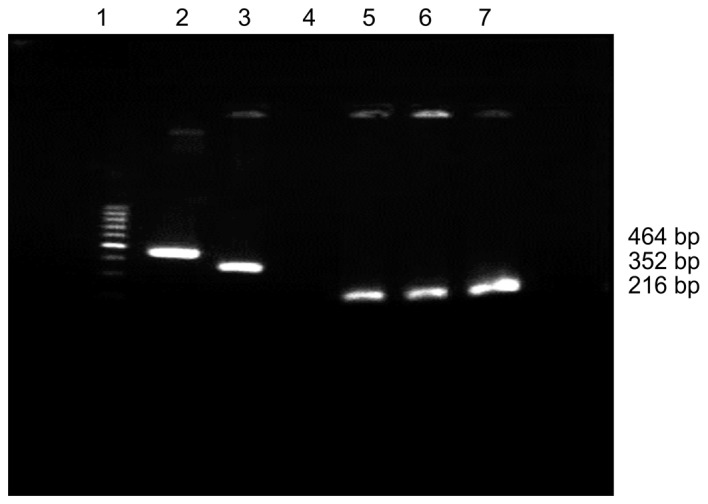
Hepatitis B viral virus X protein (HBx) fragments amplified by PCR from pAS2-1 recombinant plasmid and separated by gel electrophoresis (0.6% agarose). The different fragments have the expected molecular weights. Lane 1, 100-bp DNA ladder used as molecular weight marker; lane 2, full length (464 bp) HBx gene; lane 3, HBx X2 (352 bp) fragment; lane 4, negative controls; lanes 5–7, HBx X1 (216 bp) fragment.